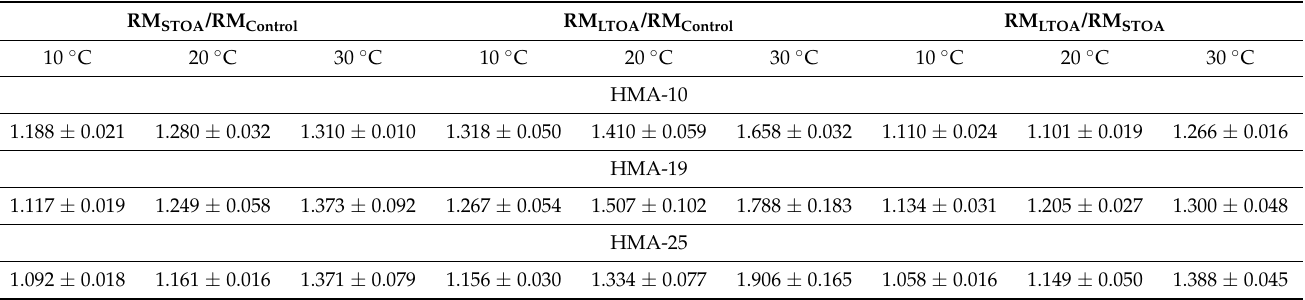
Figure 6. RM LTOA /RM Control ratio at ( a ) 10 °C, ( b ) 20 °C, and ( c ) 30 °C.